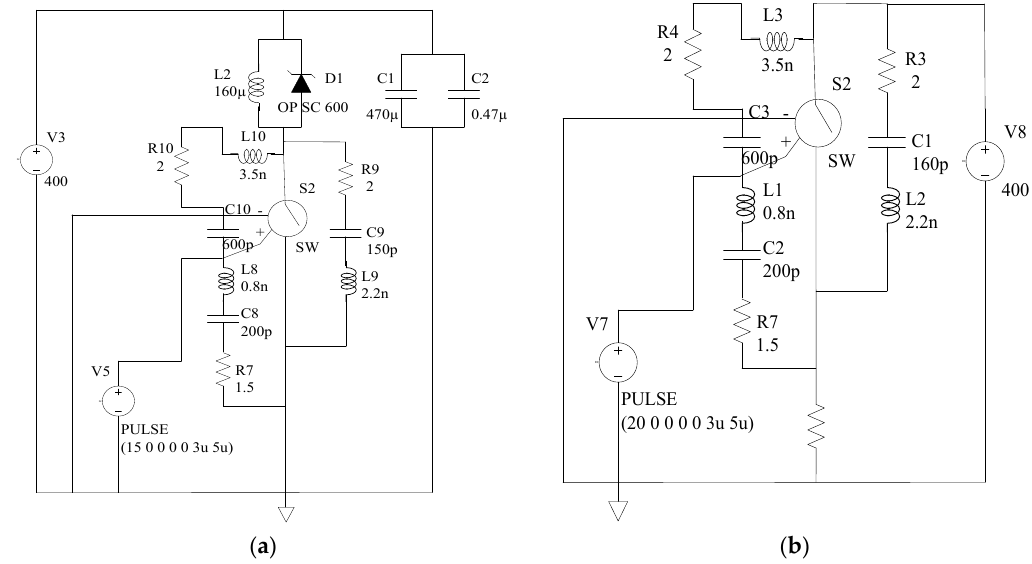
Figure 16. ( a ) Proposed behavioural model for GaN HEMT; and ( b ) DPT simulation of the proposed model.